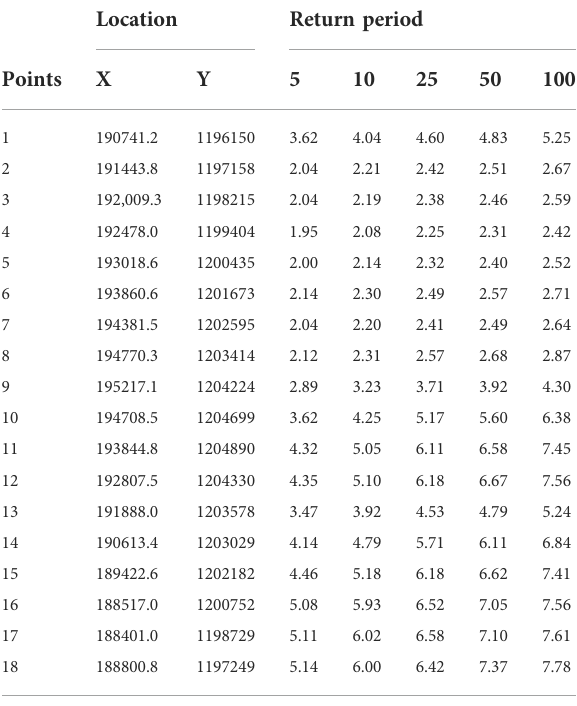
TABLE 7 Extreme wave heights for various return periods using GEV monthly maximum at water depth of 10 m.